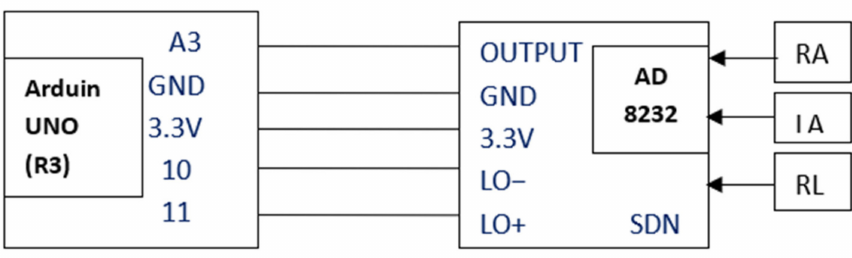
Figure 4. Pin connection and electrode placement of